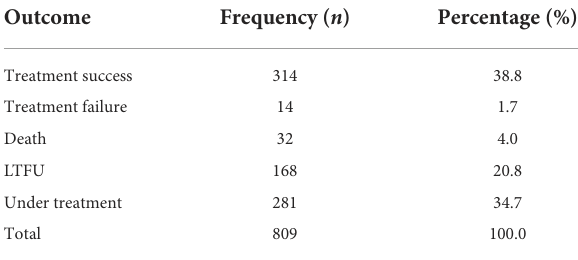
TABLE 1 Distribution of treatment outcomes in 809 patients with drug-resistant tuberculosis in Guangzhou, China, from 2016 to 2020.